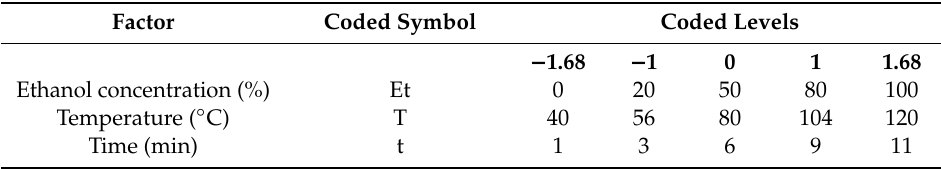
Table 1. Coded levels and experimental values of the factors used in the central composite rotatable